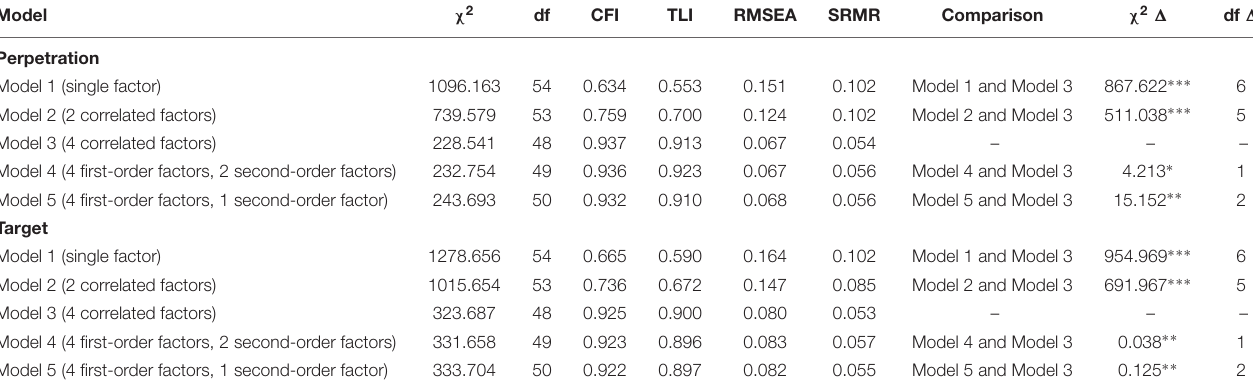
TABLE 2 | Study 2 Chi-square difference tests for perpetration and target versions of the DIRRS. Model